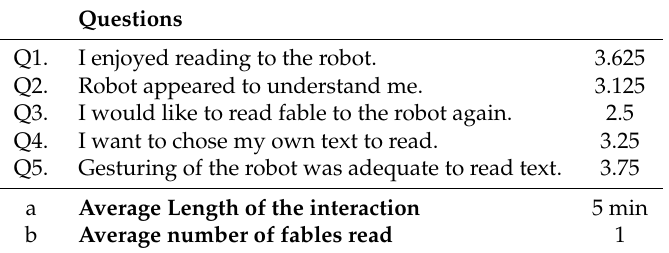
Table 17. Results from experiment